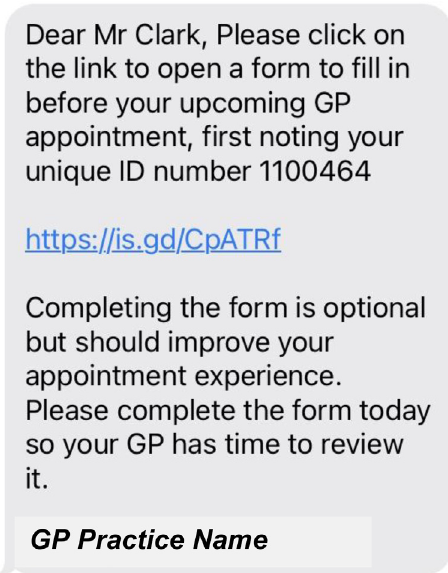
Figure 7. Pre-consultation form: Patient SMS message received.